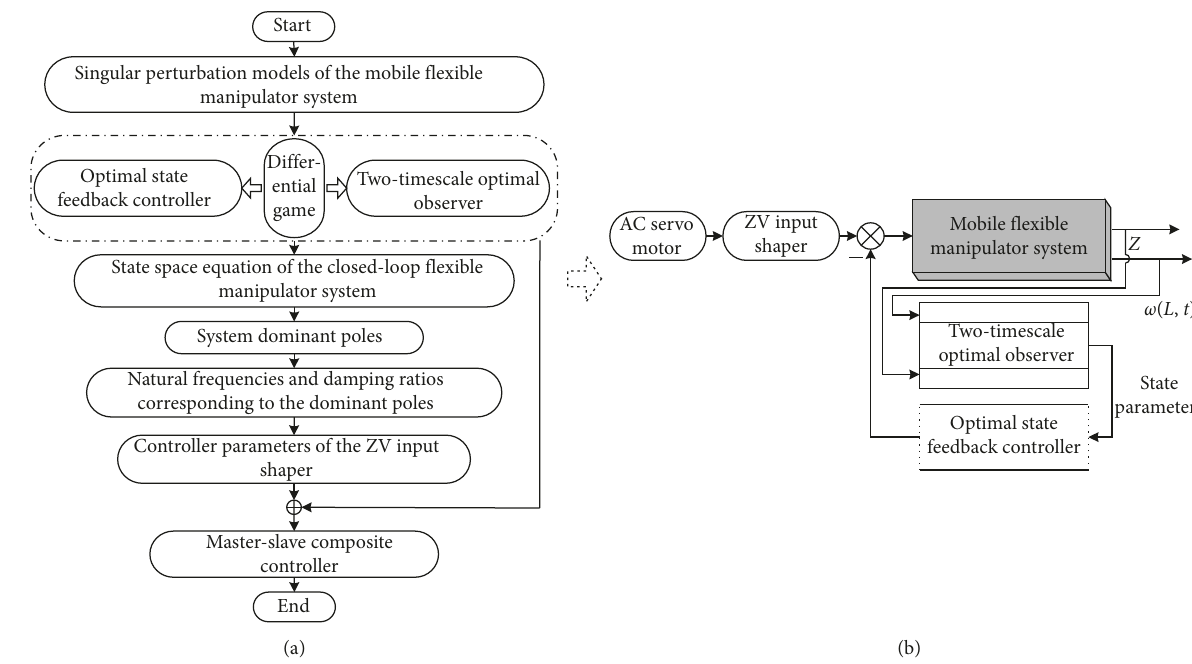
Figure 2: Design process and structure of the master-slave composite controller: (a) design process and (b)